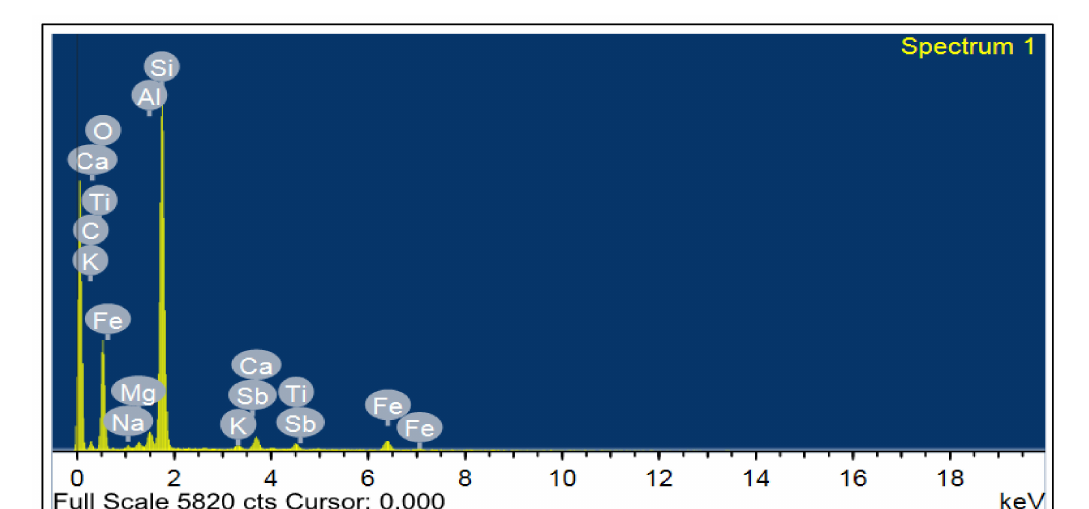
Figure 4. Black sand EDX analysis